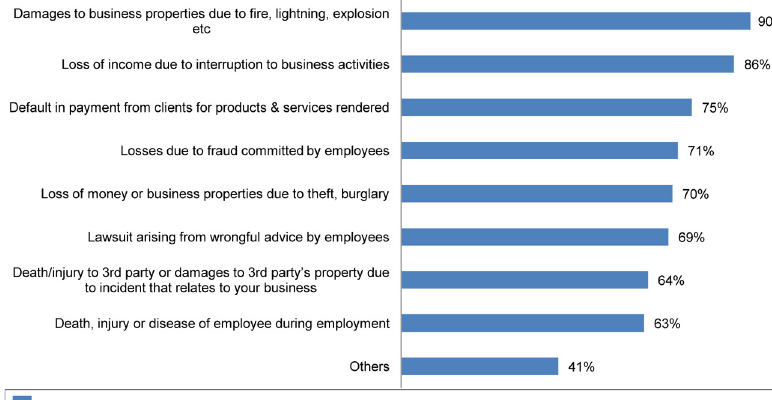
Figure 10. Ranking